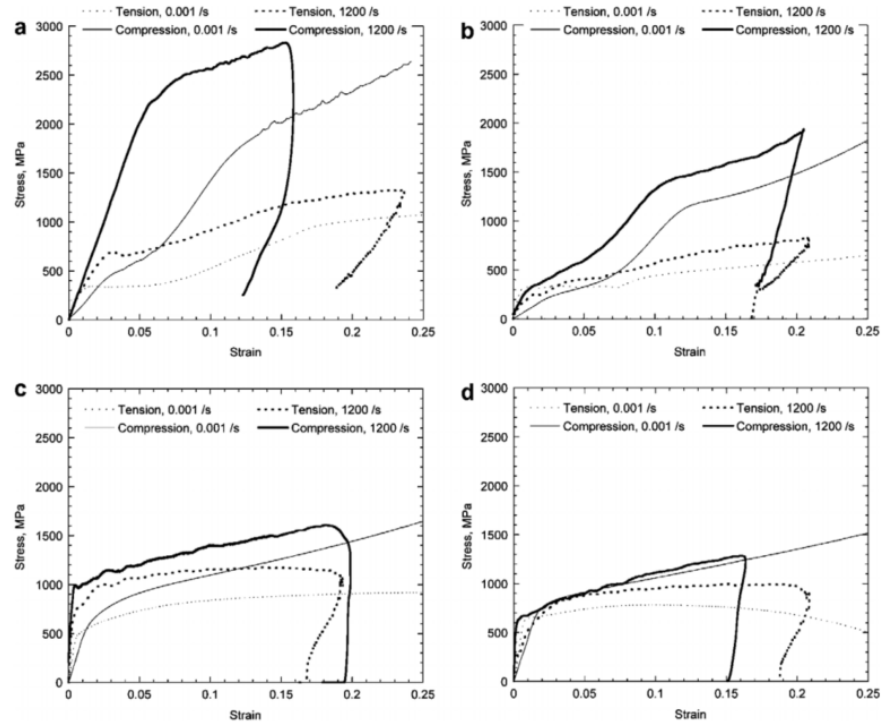
Figure 5. Compression and tension stress-strain curves of NiTi SMA. The effect of temperature on compression-tension asymmetry at dynamic (10 3 s −1 ) and quasi-static (10 −3 s −1 ) strain rates. ( a – d ) are at − 196 °C, 0 °C, 200 °C, and 400 °C, respectively [63]. (Reprinted from Ref. [63], Fig. 5, 2006, with permission from Elsevier.)